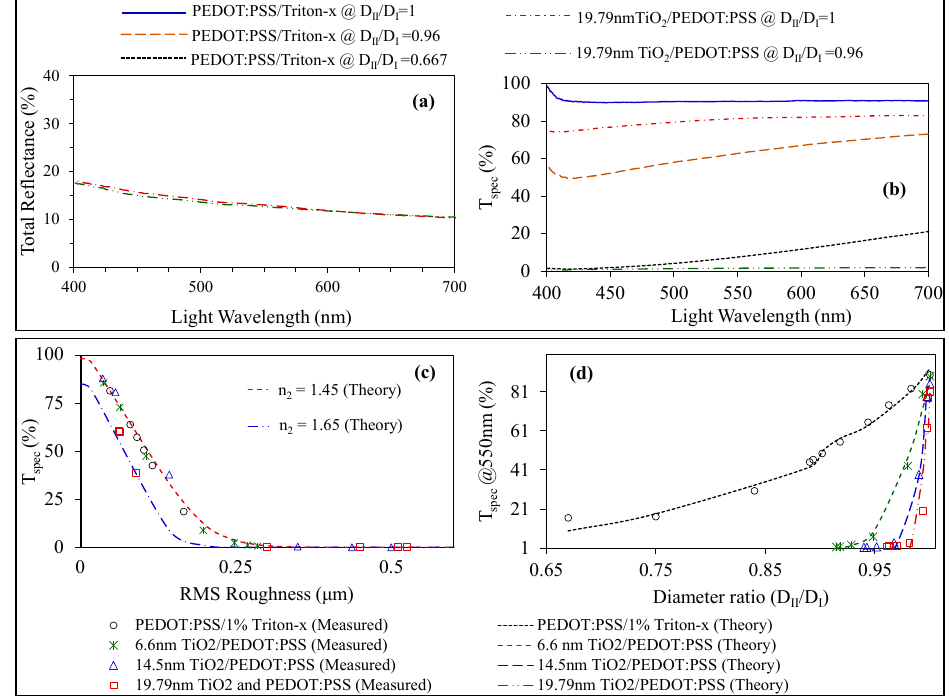
Figure 5. ( a ) Total reflectance of the TiO 2 /PEDOT:PSS films at flat and wrinkled states; ( b ) comparison of inline transmission throughout visible spectrum for the devices with coats of PEDOT:PSS and TiO 2 /PEDOT:PSS at different compression strain. The trend of reduction in inline transmission with increasing: ( c ) RMS roughness validated experimentally and theoretically; ( d ) with increasing radial compression for different TiO 2 thickness (theoretical results are based on Equation (1) validated with the experimental results).